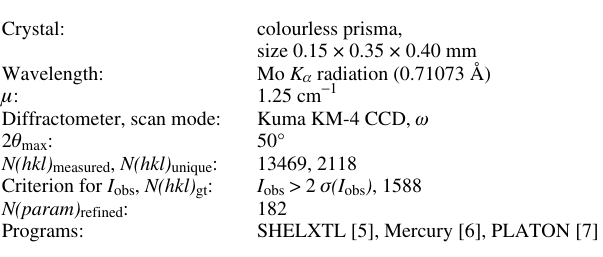
Table 1. Data collection and handling.